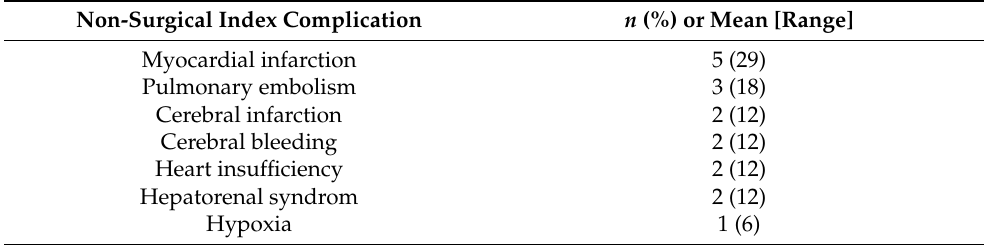
Table 2. Non-surgical causes of death in patients with in-hospital mortality after pancreatic